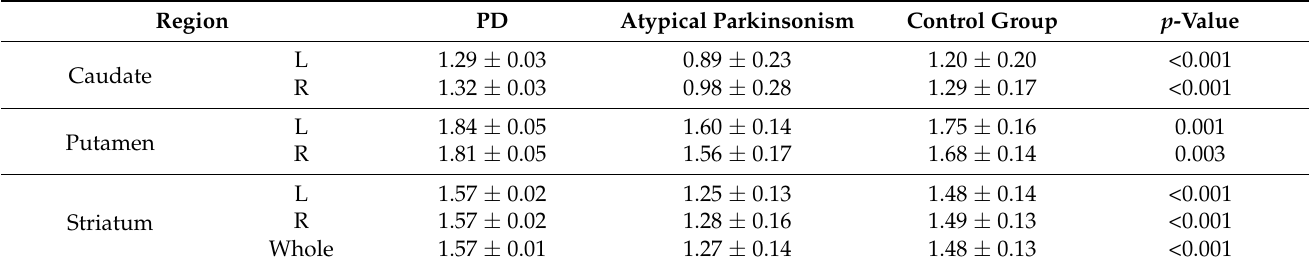
Table 2. Striatal SUVRs of the study groups.